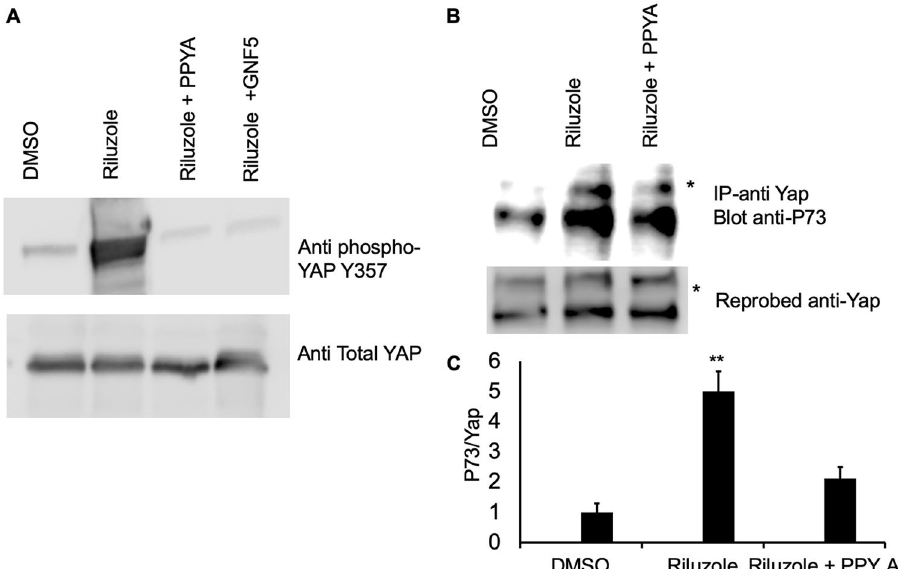
Figure 5. Riluzole induces phosphorylation of YAP at Y357 to promote binding of YAP with p73. ( A ) Whole cell extracts of treated LM7 cells with DMSO, Riluzole (50 μM) or Riluzole (50 μM) + PPY A (20 nM) were blotted with rabbit anti-YAP (phosphoY357) antibody and the blot was reprobed with mouse anti-YAP antibody. ( B ) Co-immunoprecipitation was performed to assess interaction between endogenous YAP and p73 using whole cell extracts. Samples were immunoprecipitated with mouse anti-YAP antibody and the western blot was probed with rabbit anti-p73 antibody, the blot was reprobed with mouse anti-YAP antibody. An asterisk next to the band indicates a nonspecific band. ( C ) The densities of the immunoprecipitated p73 and YAP were quantified to measure the ratio of p73/YAP. These experiments were repeated three times to confirm the results, p value < 0.05**, IP